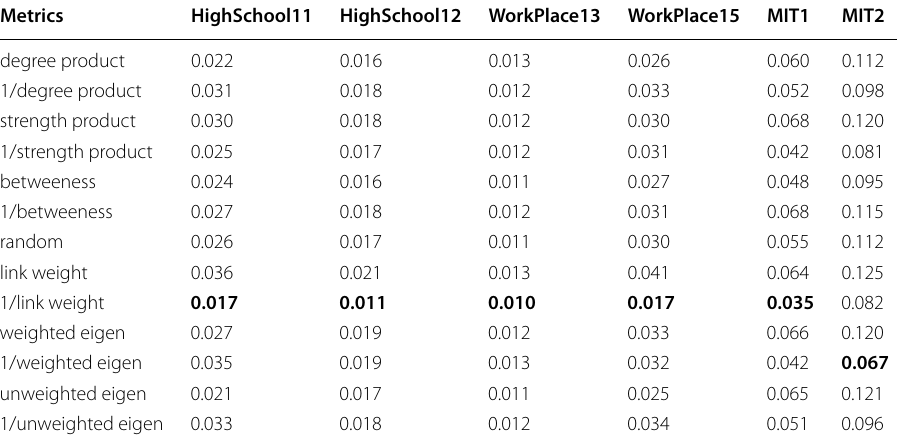
The lowest average prevalence value for each dataset is highlighted in bold